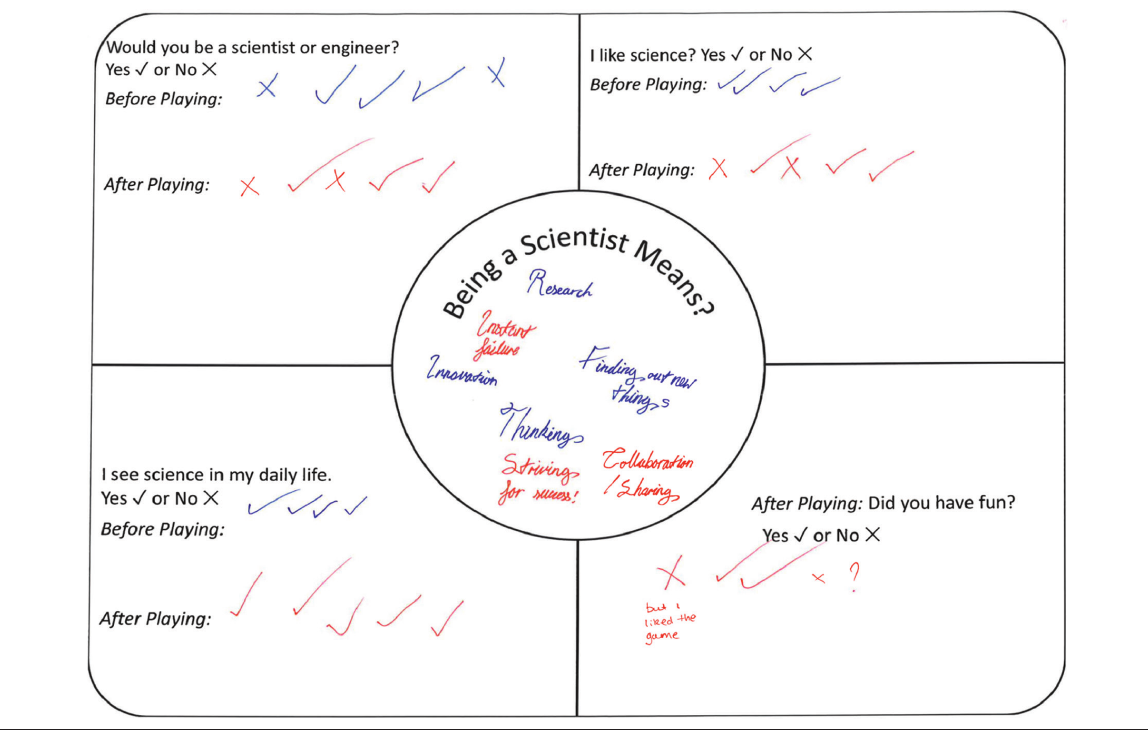
Figure 8. An example of a completed questionnaire received from the participants (Source: Authors,